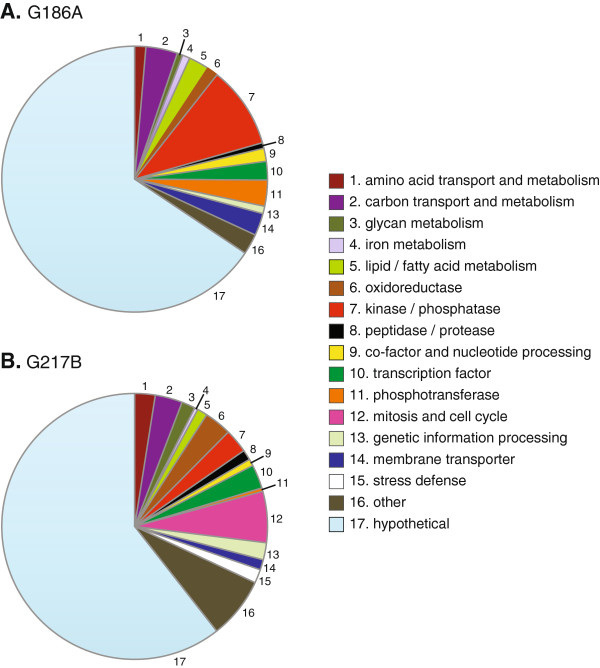
Functional classification of G186A- and G217B- enriched genes. Chart depicts the proportion of genes that show increased expression in G186A (A) or G217B (B) by the putative functional class of the encoded gene product. Genes encoding factors with no identifiable function based on protein sequence homology were categorized as “hypothetical.”